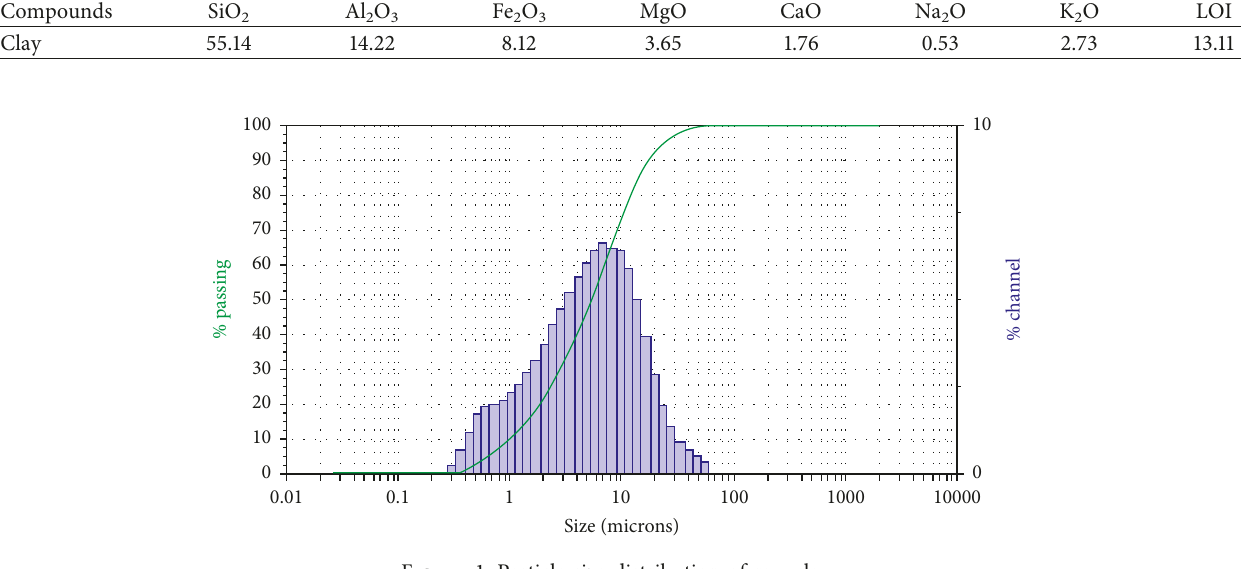
Figure 1: Particle size distribution of raw clay. Table 2: Preview of the experimental